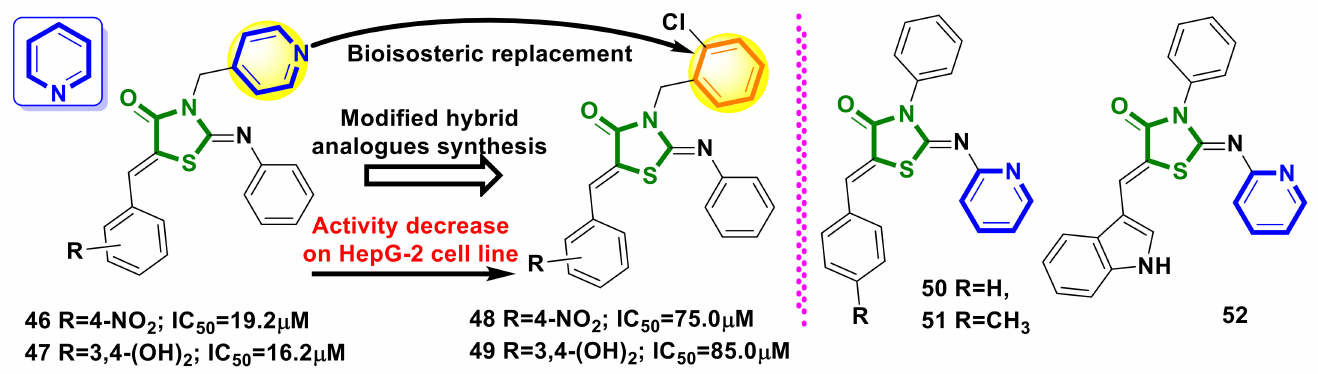
Figure 20. The structures and SAR of pyridine–4-thiazolidinone hybrids with anticancer